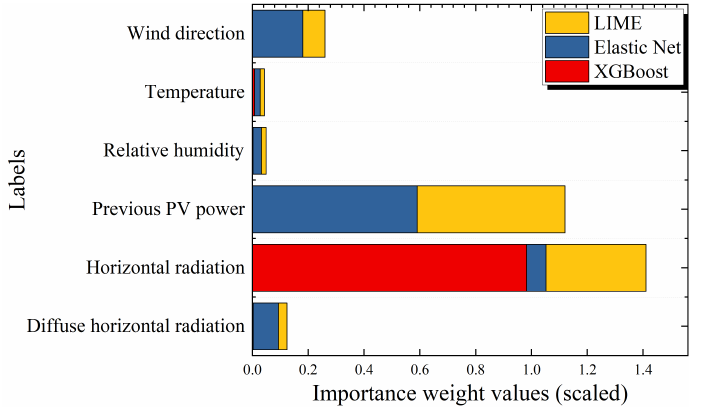
Figure 8. Relative importance of the candidate variables, using LIME, Elastic Net, and